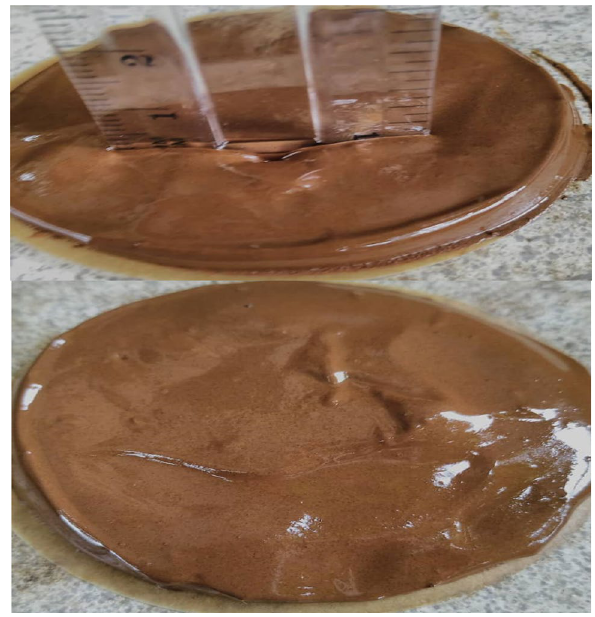
Fig. 9 Filter cake from the filtration test and its